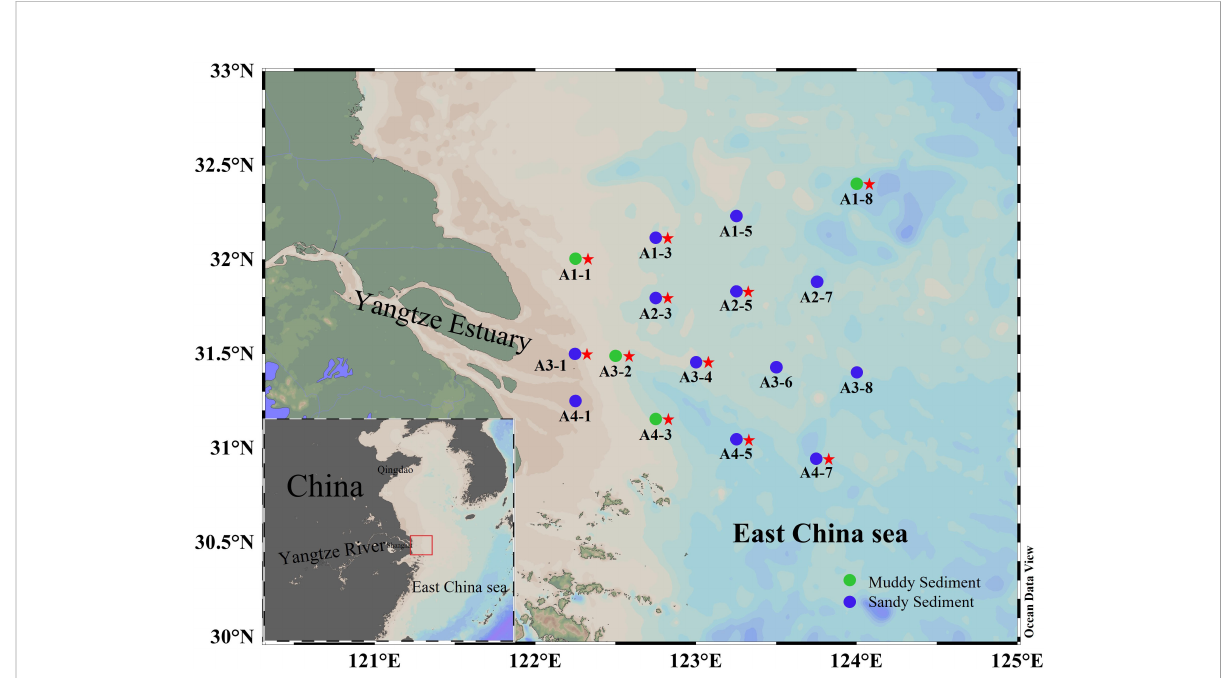
FIGURE 1 The map of sediment sampling stations. The dots represented sampling sites (green dots denoted muddy sediments and blue dots denoted sandy sediments). The red stars represent that the key functional genes were analyzed by high-throughput sequencing in these sampling